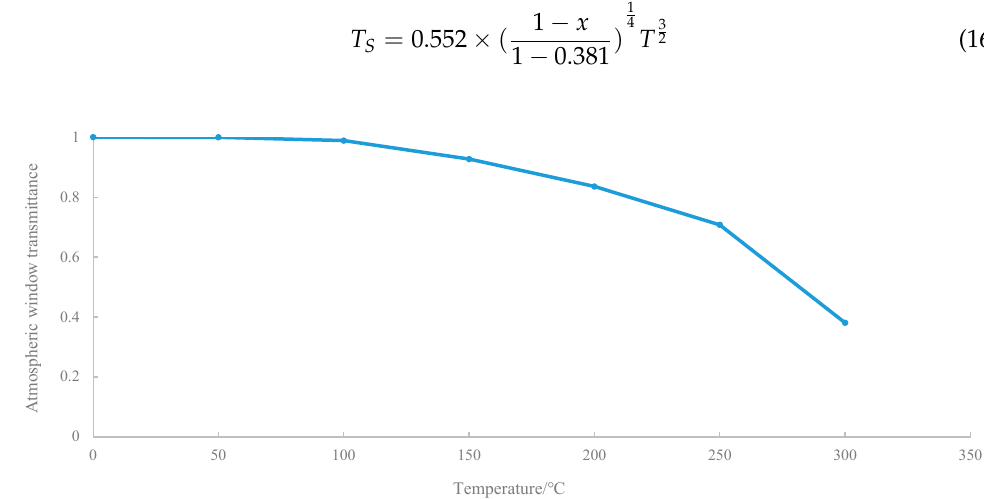
Figure 14. Atmospheric window transmittance versus effective sky temperature curve.